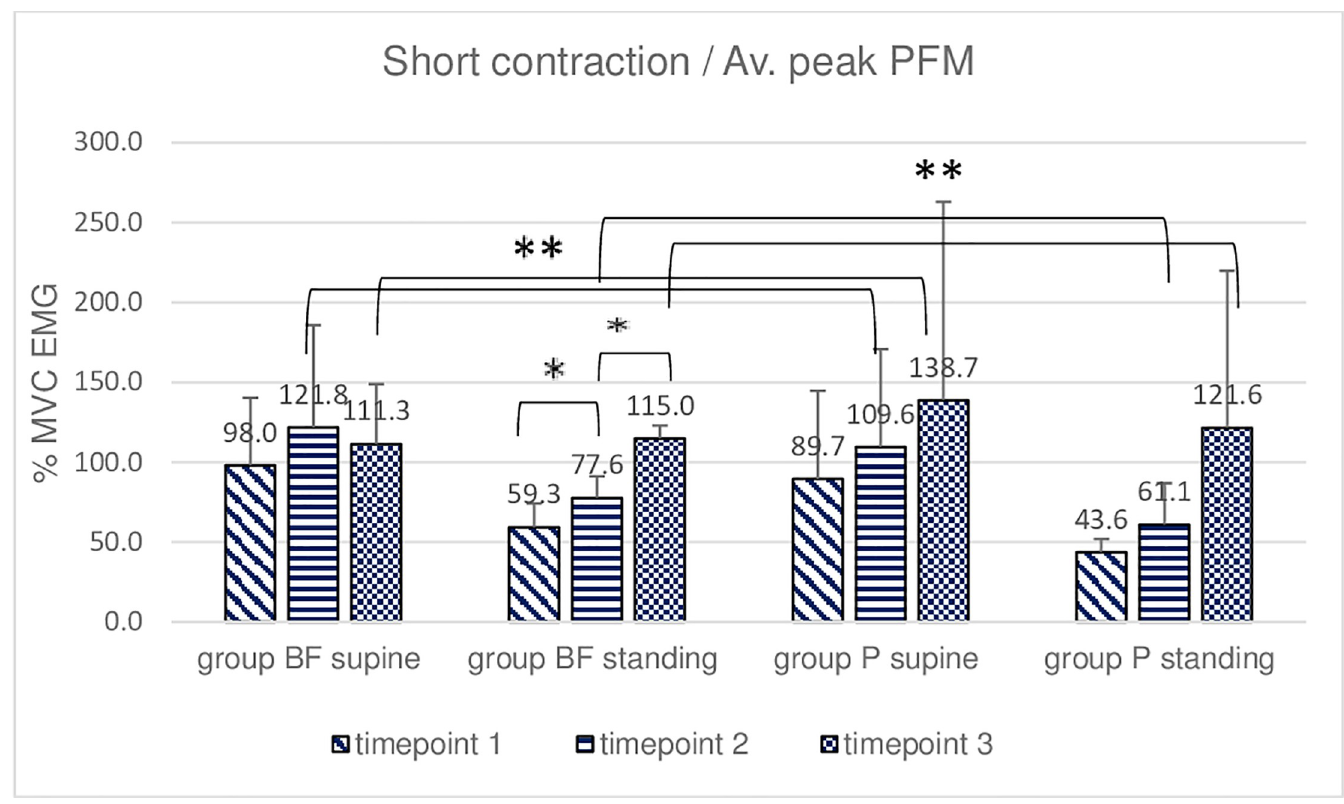
Fig 3. Intra- and intergroup analysis of sEMG average peak %MVC amplitudes of the short contraction of the pelvic floor muscles; p � Post-hoc Friedman’s rank sum